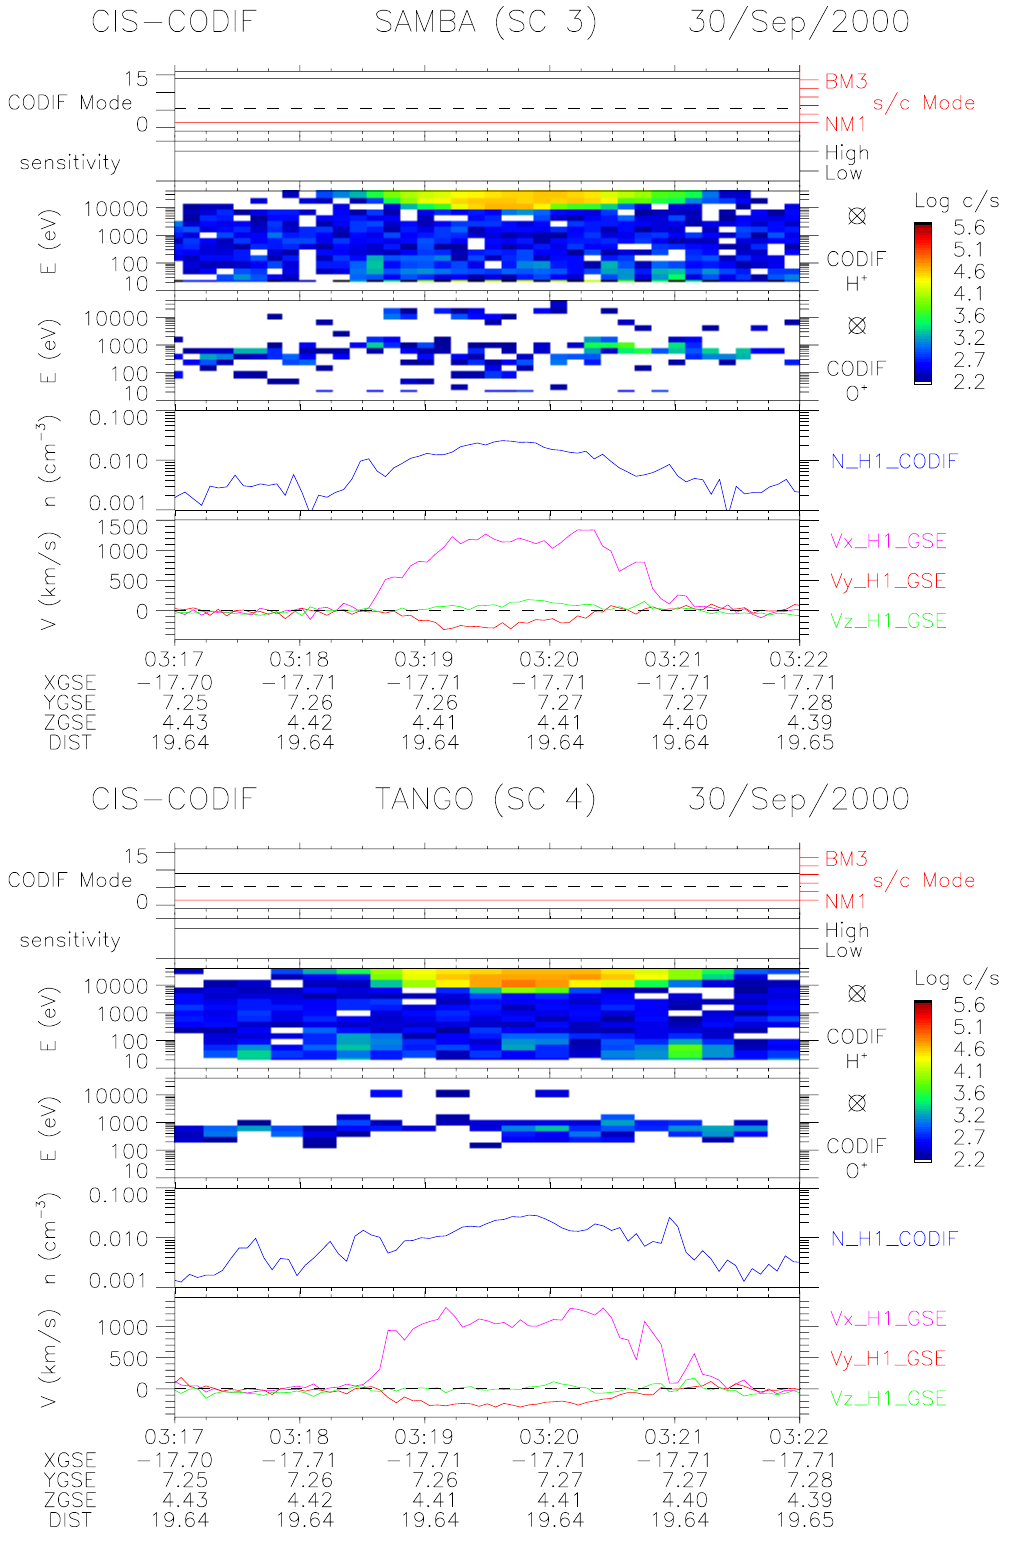
Fig. 23. Simultaneous measurements on 30 September 2000 between 03:17 and 03:22UT with spacecraft 3 (CODIF) and spacecraft 4 (CODIF). See caption of Fig. 22 for the description of the